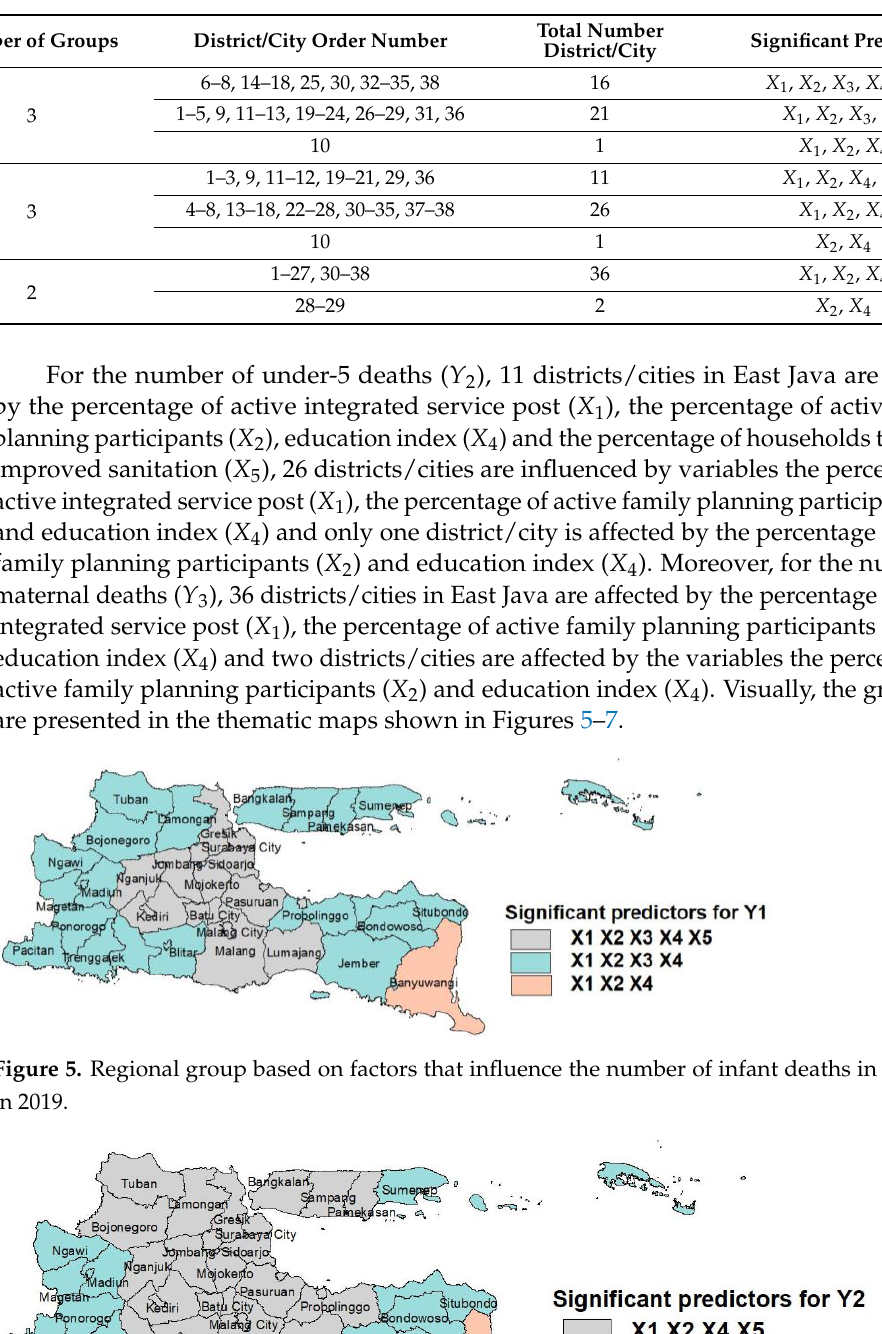
Figure 7. Regional group based on factors that influence the number of maternal deaths in East Java in 2019. 5. Conclusions The GWMPIGR model is a point-based spatial regression model where the parameter estimator is influenced by location effects. In this study, four GWMPIGR models were constructed based on exposure and spatial weighting functions: the fixed Gaussian kernel function and the Bisquare fixed kernel function. Based on the AICc value, the GWMPIGR model with the fixed Gaussian kernel weighting function and the number of live births as the exposure was better at modeling data on the number of infant, under-5 and maternal deaths in East Java in 2019. Several regional groups in East Java were formed based on predictors that significantly affect each event. However, further research, such as simula- tion studies, is needed to evaluate the proposed method.